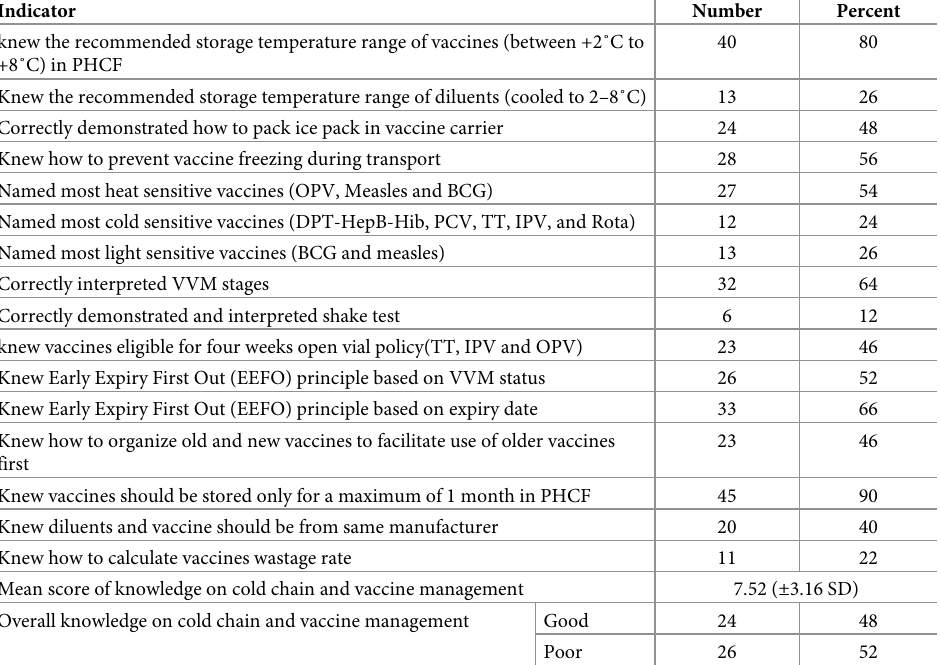
Table 2. Knowledge of vaccine handlers on cold chain and vaccine management in primary health care facilities of Tigray region, Northern Ethiopia, 2019 (N = 50). Indicator Number Percent knew the recommended storage temperature range of vaccines (between +2˚C to 40 80 +8˚C) in PHCF Knew the recommended storage temperature range of diluents (cooled to 2–8˚C) 13 26 Correctly demonstrated how to pack ice pack in vaccine carrier 24 48 Knew how to prevent vaccine freezing during transport 28 56 Named most heat sensitive vaccines (OPV, Measles and BCG) 27 54 Named most cold sensitive vaccines (DPT-HepB-Hib, PCV, TT, IPV, and Rota) 12 24 Named most light sensitive vaccines (BCG and measles) 13 26 Correctly interpreted VVM stages 32 64 Correctly demonstrated and interpreted shake test 6 12 knew vaccines eligible for four weeks open vial policy(TT, IPV and OPV) 23 46 Knew Early Expiry First Out (EEFO) principle based on VVM status 26 52 Knew Early Expiry First Out (EEFO) principle based on expiry date 33 66 Knew how to organize old and new vaccines to facilitate use of older vaccines 23 46 first Knew vaccines should be stored only for a maximum of 1 month in PHCF 45 90 Knew diluents and vaccine should be from same manufacturer 20 40 Knew how to calculate vaccines wastage rate 11 22 Mean score of knowledge on cold chain and vaccine management 7.52 ( ± 3.16 SD) Overall knowledge on cold chain and vaccine management Good 24 48 Poor 26